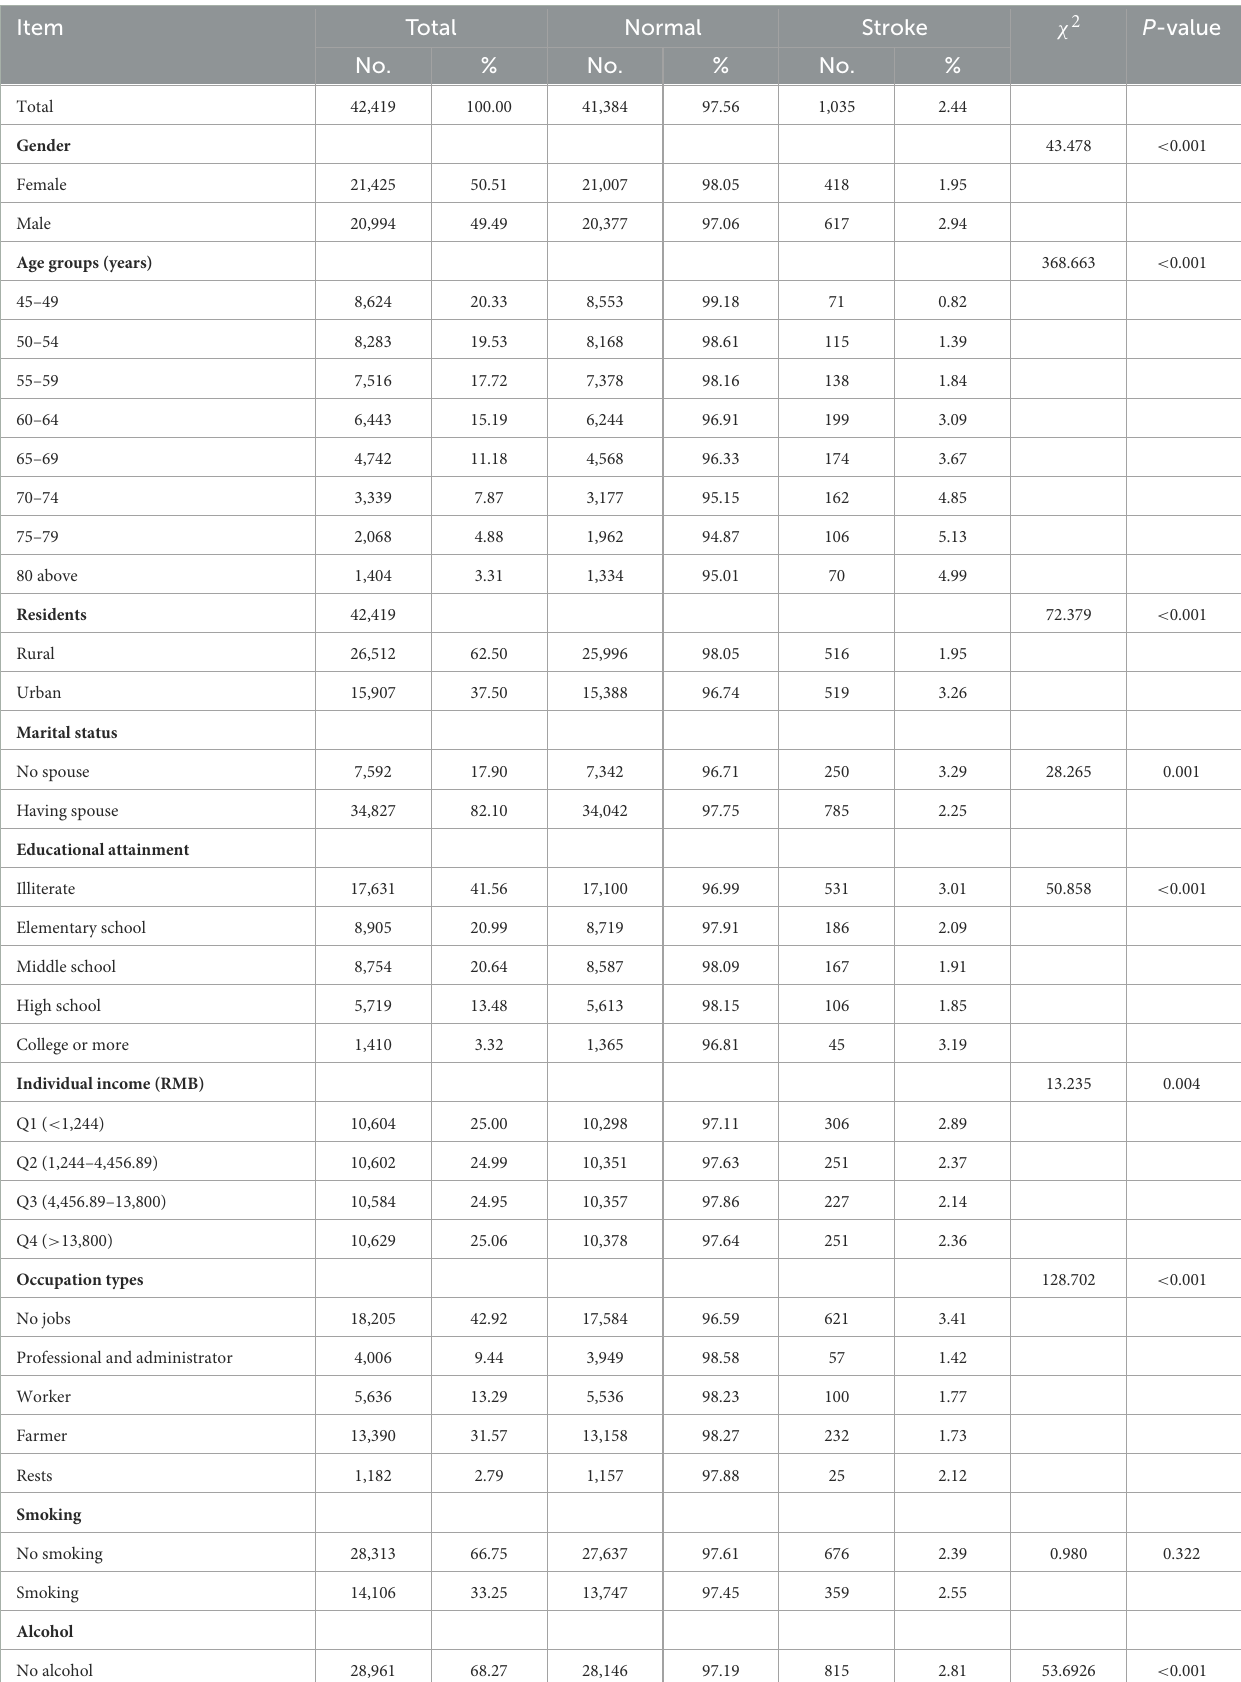
TABLE 1 General characteristics of middle-aged and older Chinese ≥ 45,